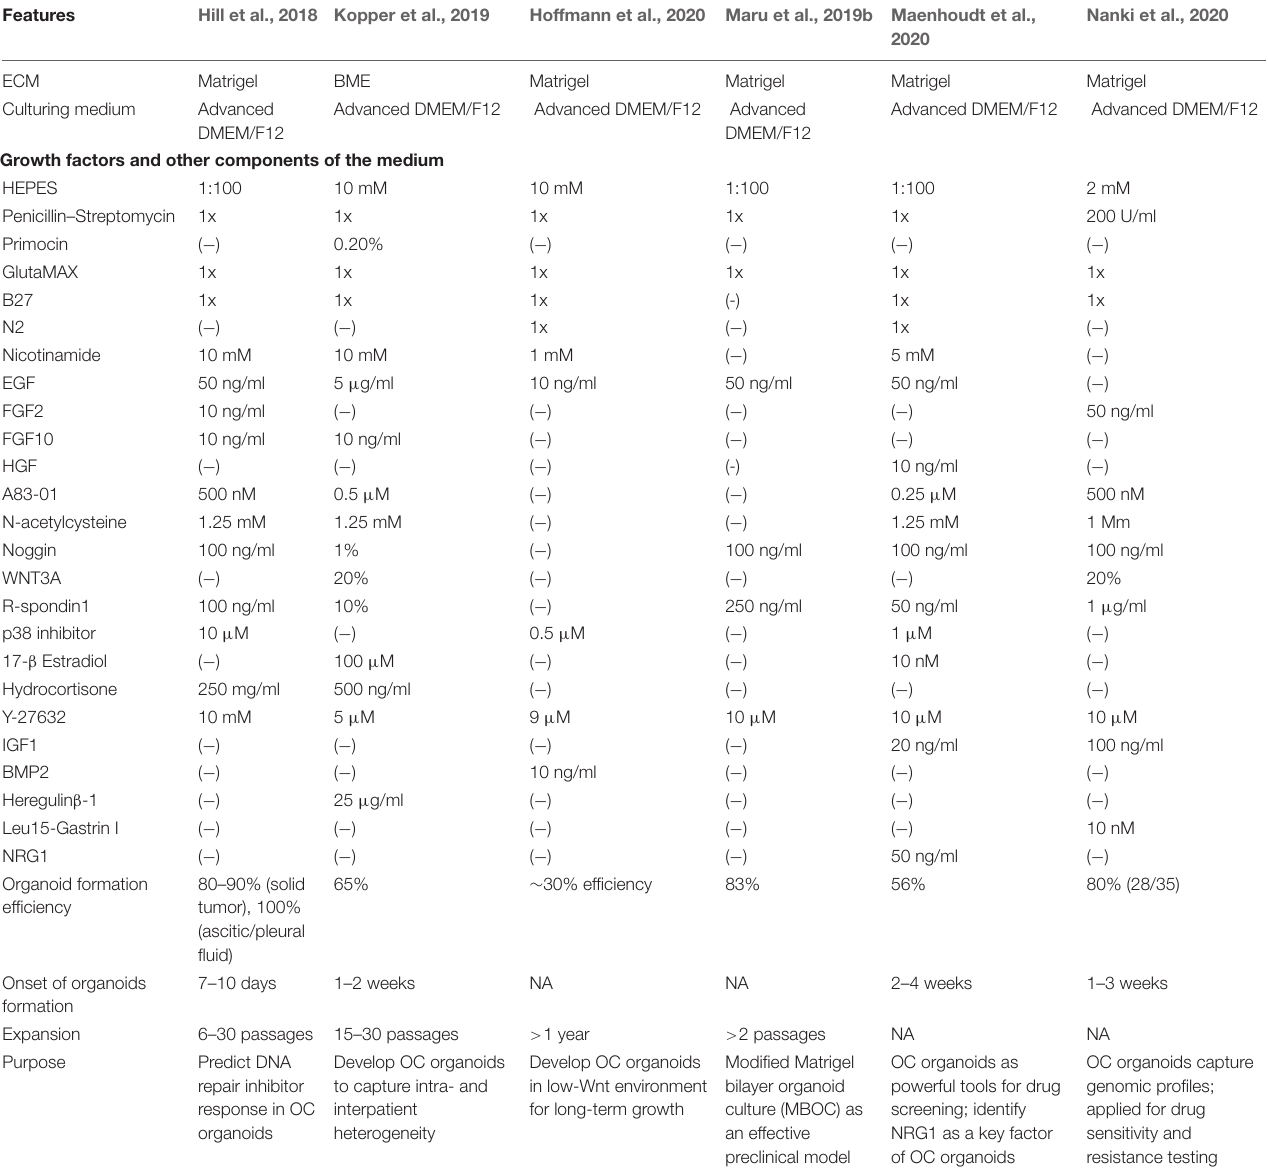
TABLE 1 | A brief overview of experimental conditions and key findings of studies on OC organoid cultures (Hill et al., 2018; Kopper et al., 2019; Maru et al., 2019b; Hoffmann et al., 2020; Maenhoudt et al., 2020; Nanki et al., 2020).